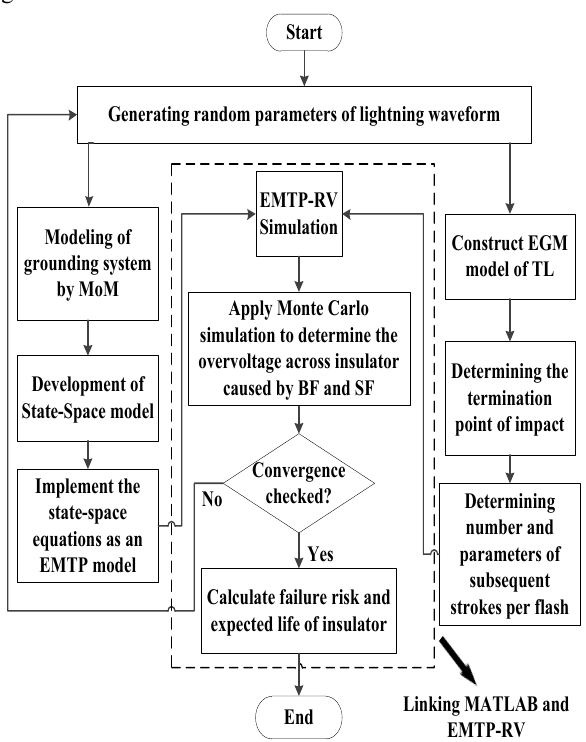
Figure 4: Flowchart of the proposed